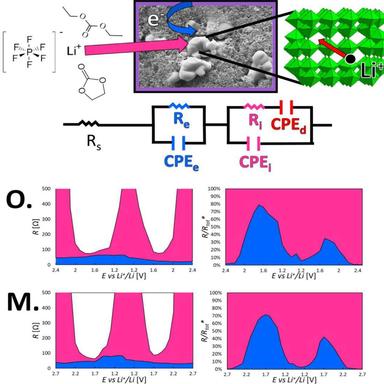
Schematic representation of the electrochemical phenomena modelled with the equivalent circuit and R vs E plots, for monoclinic and orthorhombic FeNb11O29. Ionic (pink) and Electronic (blue) resistances are plotted separately on the left and their ratio with their sum (called Rtot∗) is plotted on the right.